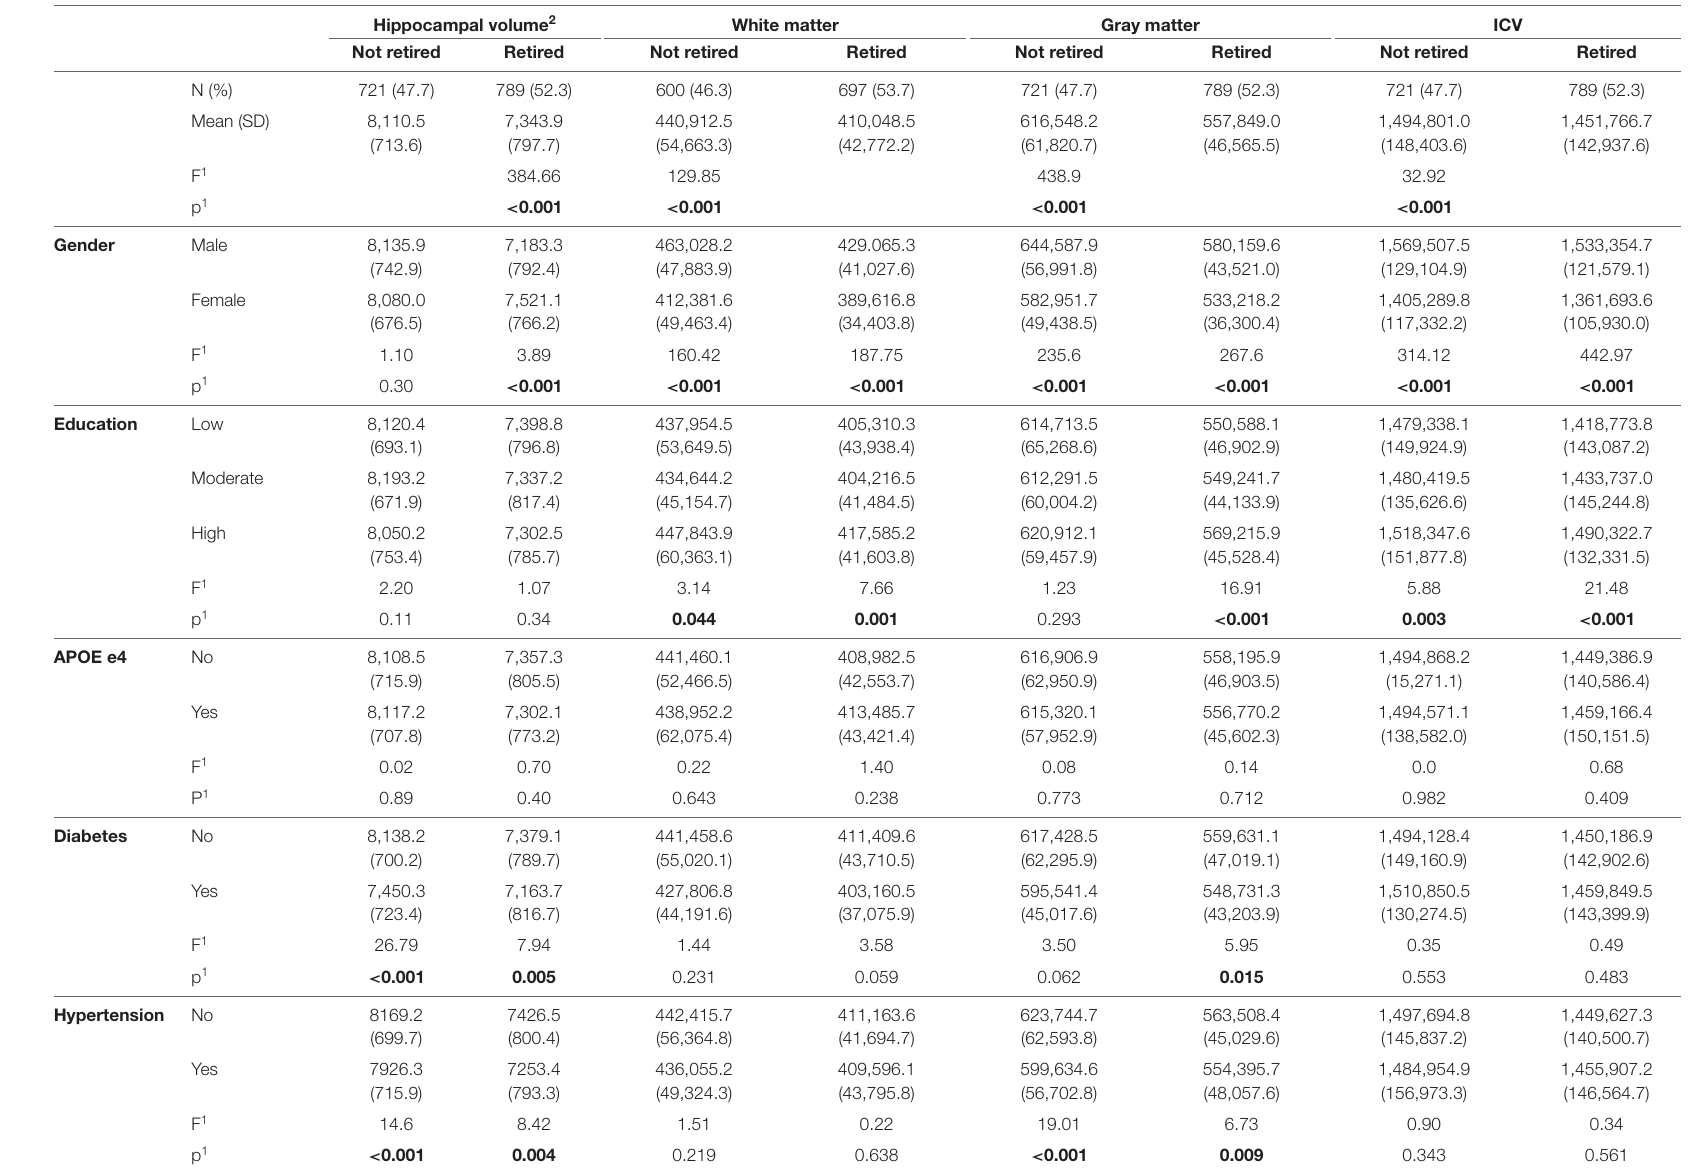
TABLE 1 | Mean hippocampal and brain volume (in mm 3 ) concerning the characteristics of the study sample ( n = 1, 409). Hippocampal volume 2 White matter Gray matter